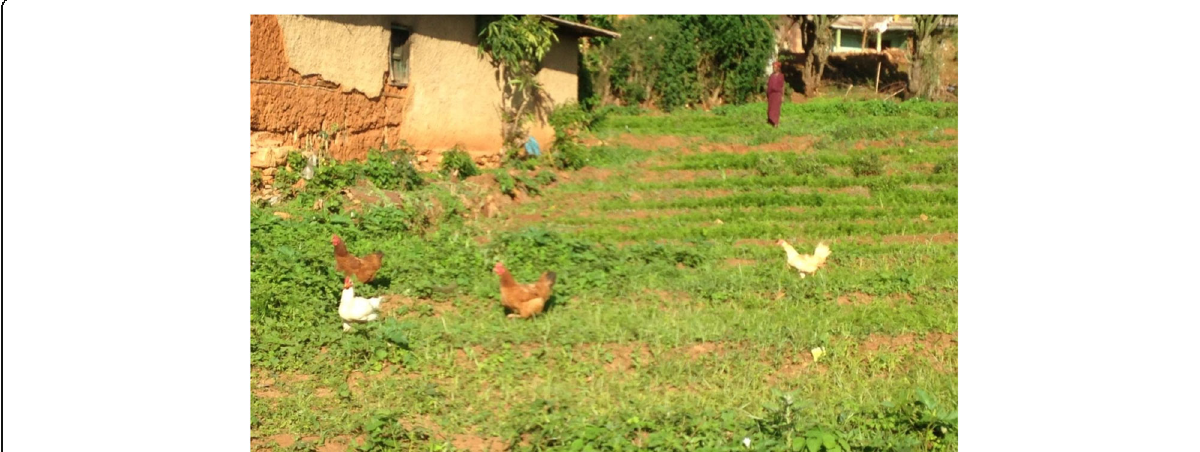
Fig. 2 Indigenous chickens running through a field in Haramaya